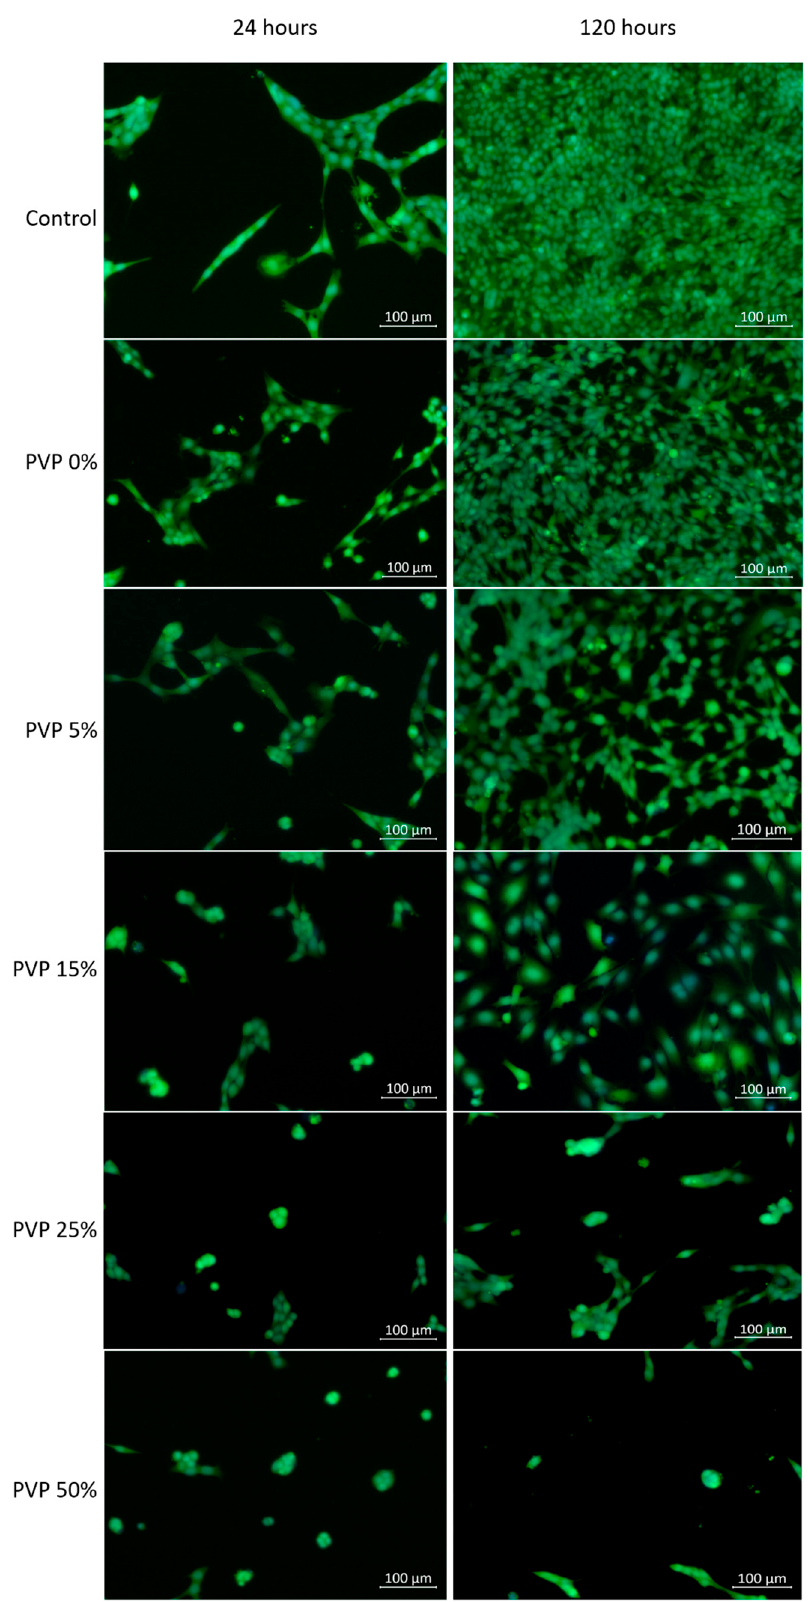
Figure 5. Images of cells on the surface of cell culture plates depending on the PVP content and culture period.